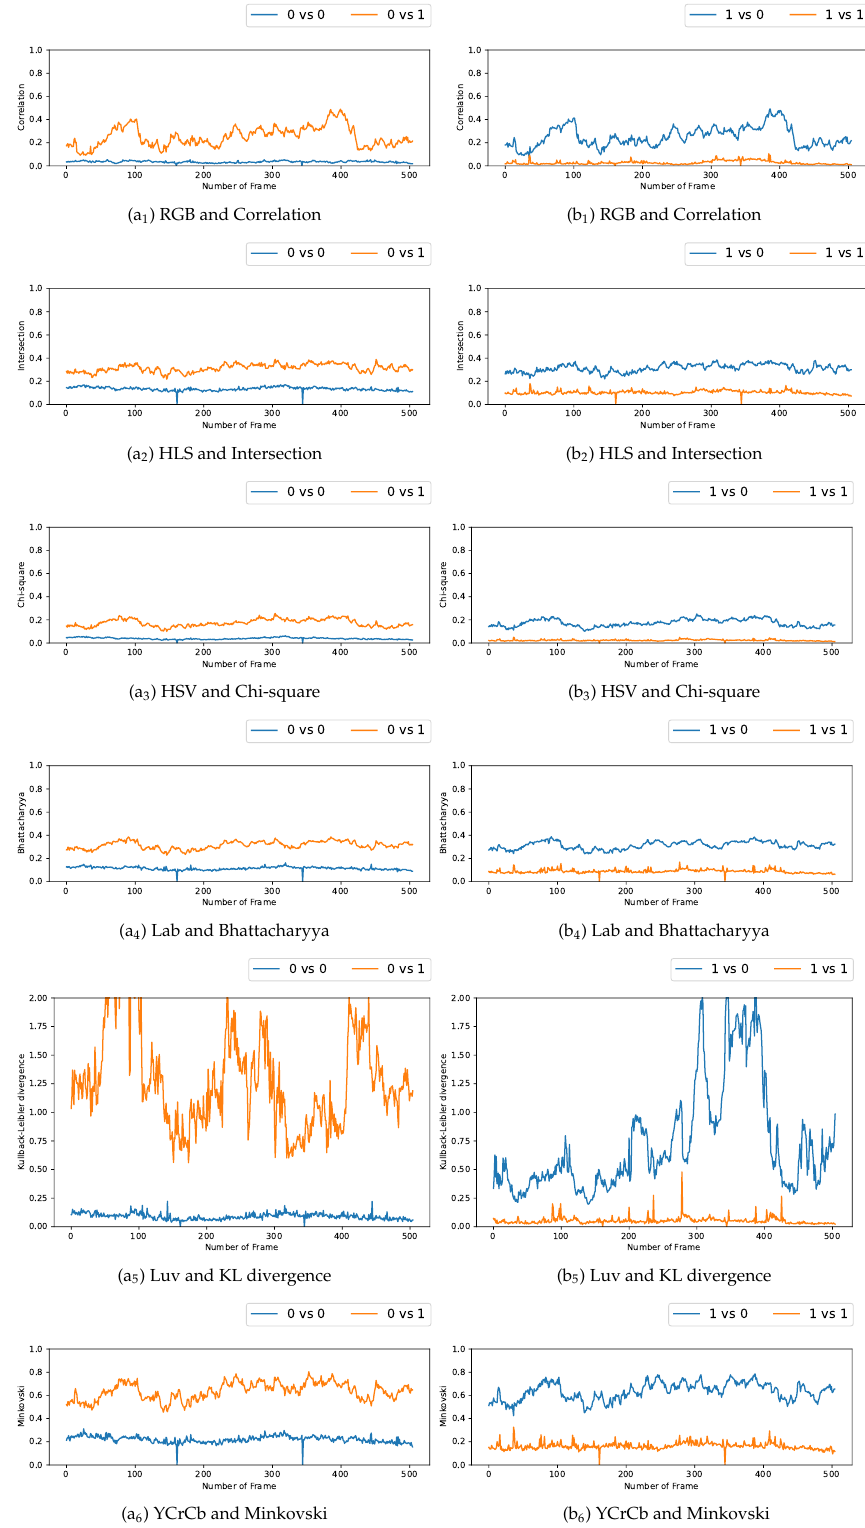
Figure 7. Curves comparing persons from one frame to another in video 3 (persons 0 and